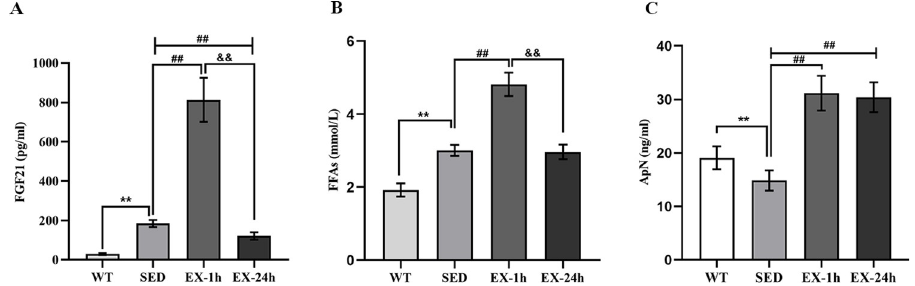
Fig 3. The effect of aerobic exercise on serum FGF21, FFAs, ApN levels. ( A ) Aerobic exercise affects serum FGF21 levels. ( B ) Aerobic exercise affects serum FFAs levels. ( C ) Aerobic exercise affects serum ApN levels (n = 8). Data are expressed as mean ± SD. � p < 0.05, �� p < 0.01 vs. WT group; ## p < 0.01 vs. SED group; && p < 0.01 vs. EX-1h